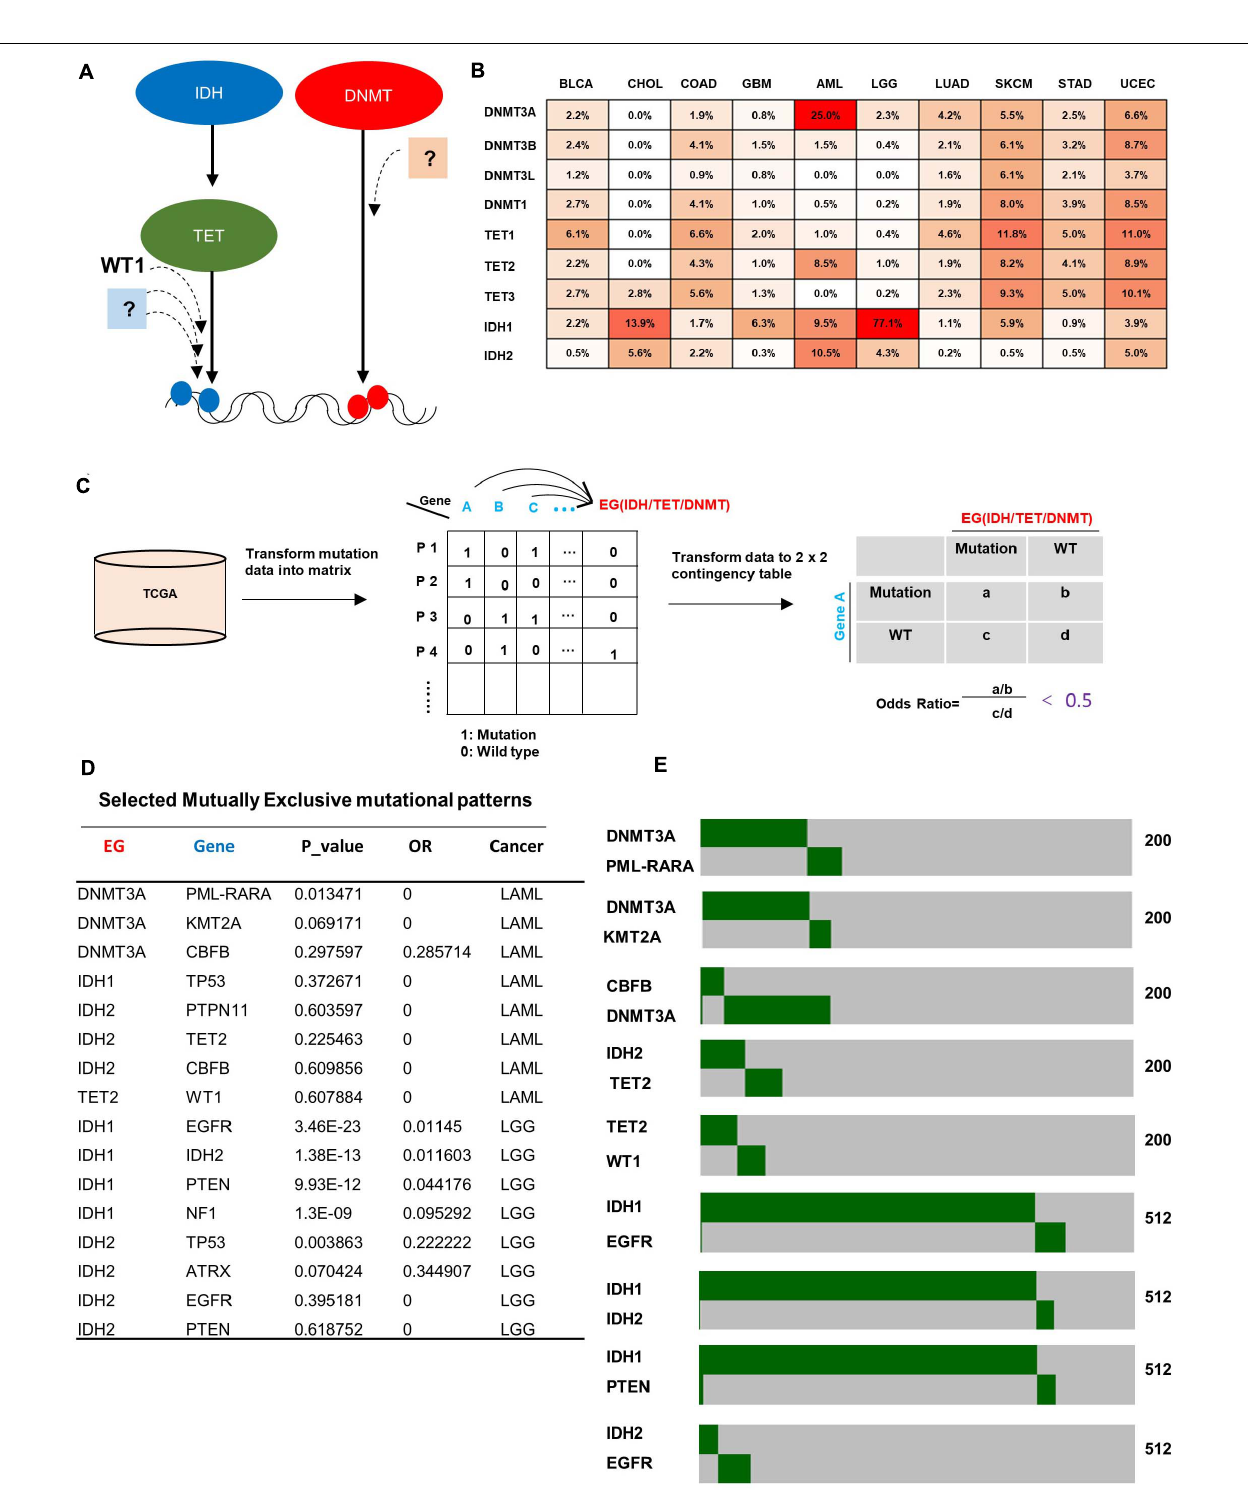
FIGURE 1 | Bioinformatic search for genes mutated mutually exclusively with genes known to be involved in DNA de/methylation. (A) Illustration of the rationale for identifying genes that may function in the same pathway with epigenetic genes. (B) Mutation rate of epigenetic genes across 10 cancer types. Data was obtained from cBioportal. (C) Schematic diagram of methodology for identifying genes that show mutual exclusivity with mutations targeting IDH, TET, and DNMT family genes. (D) Selected mutually exclusive mutation pairs in AML and LGG. (E) Heatmap showing the mutually exclusive mutational pattern of gene pairs. The number of patients for each analysis is indicated on the